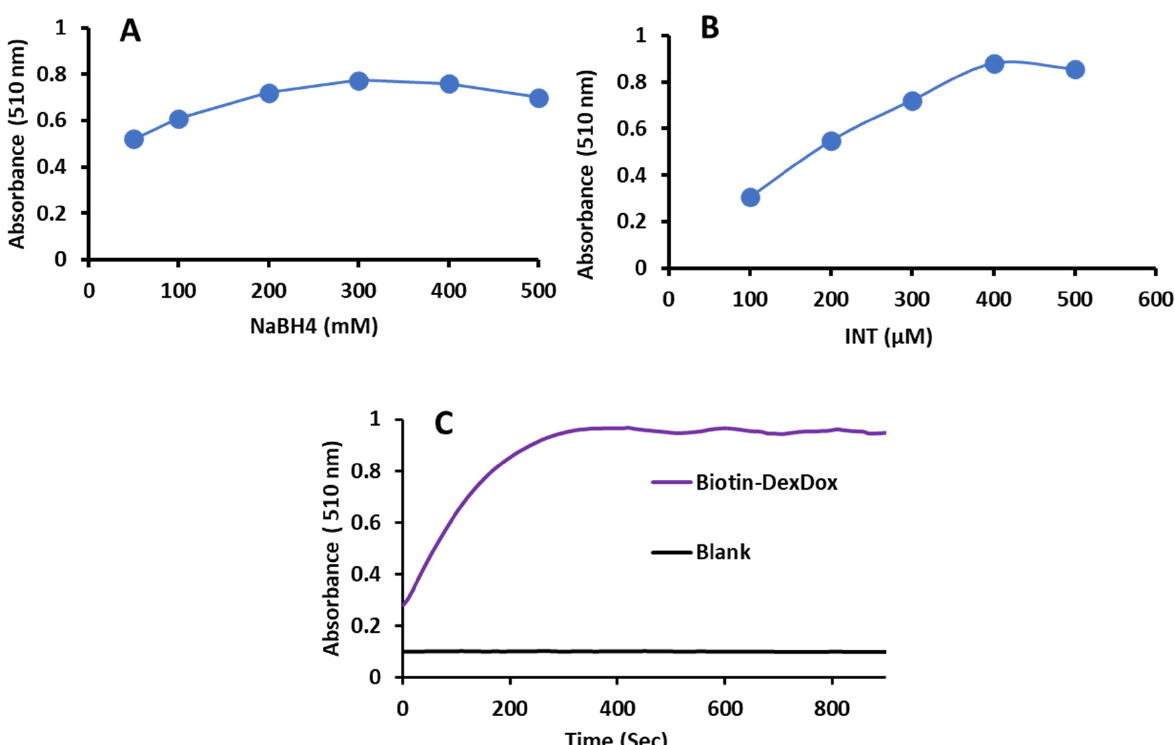
Figure 6. Effect of different parameters affecting the colorimetric reaction of Biotin-DexDox with NaBH 4 and INT on the absorbance of the reaction products, including ( A ) NaBH 4 concentration, ( B ) INT concentration, and ( C ) reaction time.